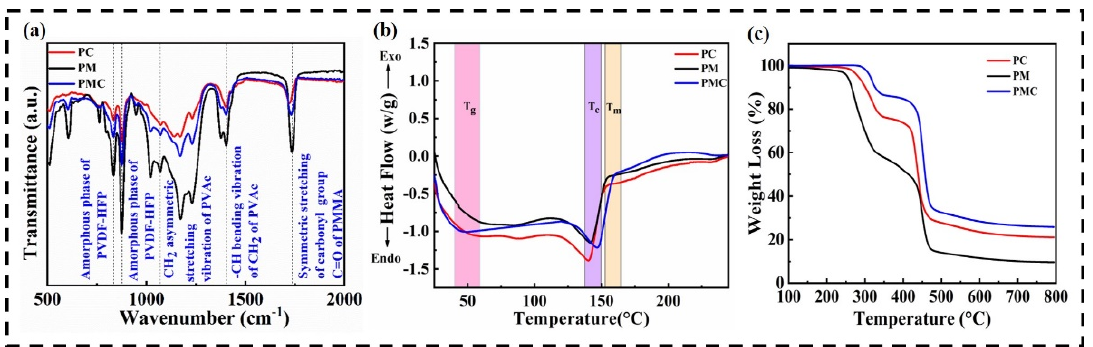
Figure 3. ( a ) FTIR spectra of PM, PC, PMC polymer membranes; ( b ) DSC curves of PM, PC and PMC polymer membranes; ( c ) TGA curves of PM, PC and PMC polymer membranes.